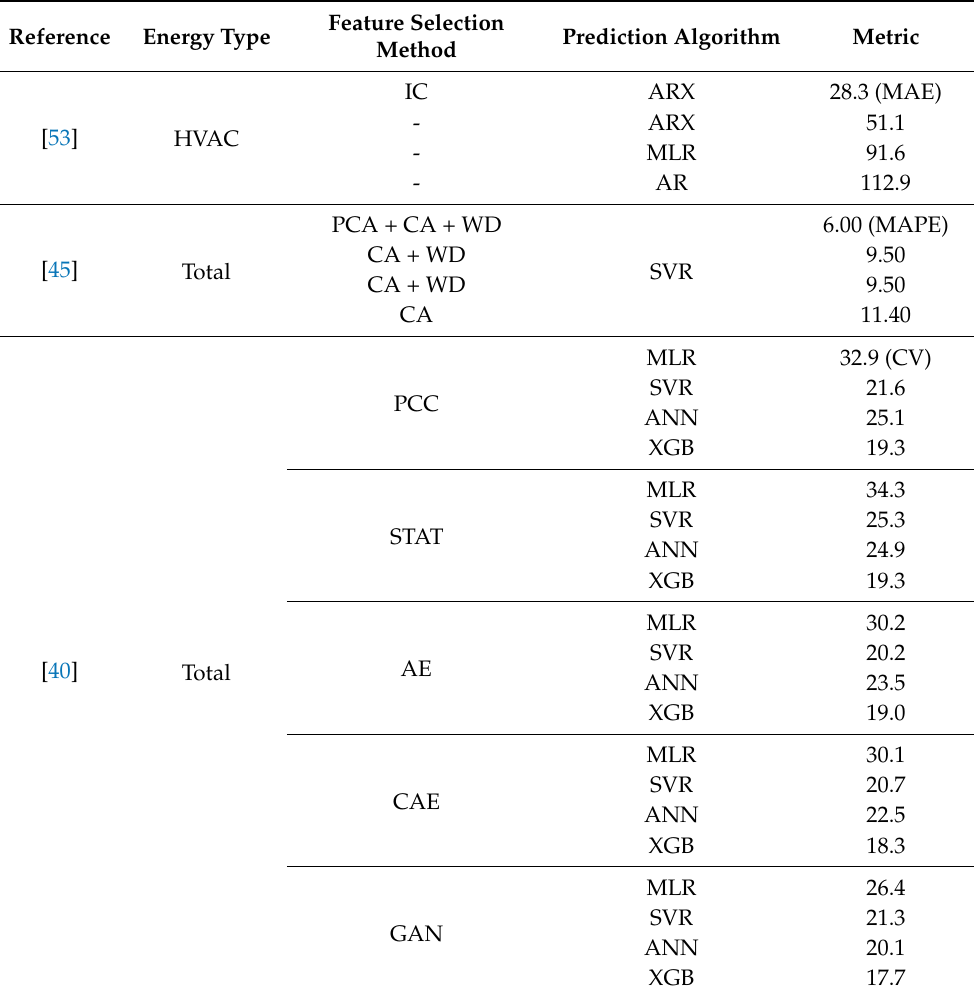
Table 3. Comparative prediction accuracy of different energy consumption feature selection